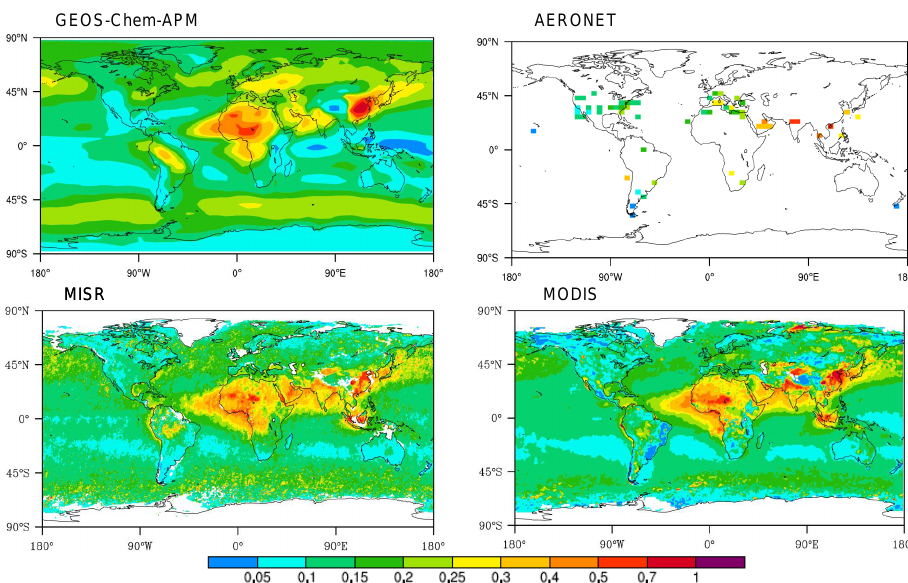
Fig. 3. Annual mean (year 2006) aerosol optical depth (AOD) from GEOS-Chem APM model at 550nm, AERONET at 500nm, MISR satellite retrieval at green band, and MODIS retrieved values at 550nm. The AERONET data are for 1996–2011, v2 level 2, annual averages for each year were used if > 8 months were present. MODIS AOD includes the values over desert areas from deep blue algorithm on board Aqua.